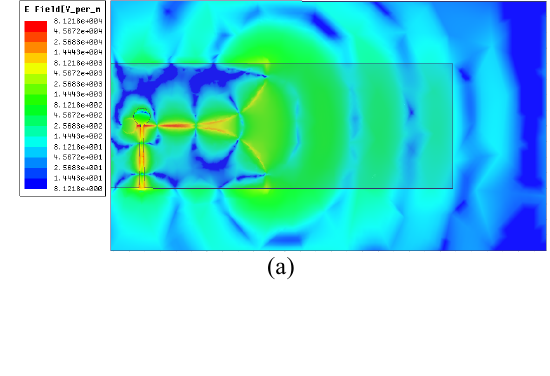
Figure 6: Metamaterial GRIN integrated